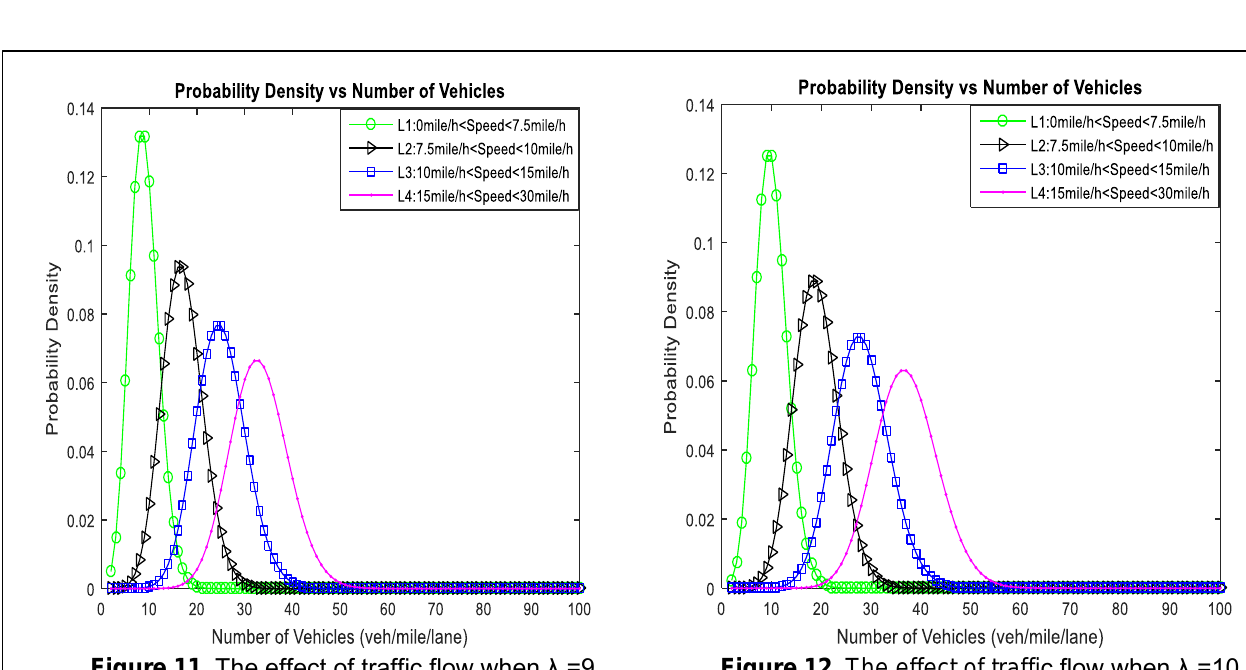
Figure 11. The effect of traffic flow when λ =9 Figure 12. The effect of traffic flow when λ